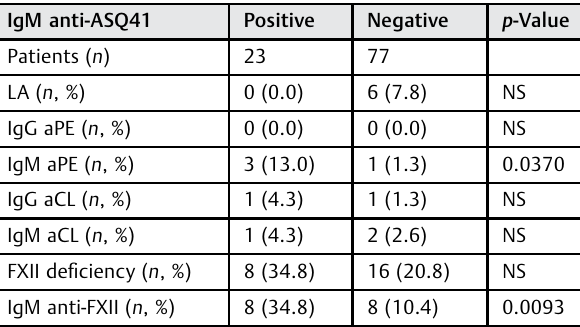
Table 2 Antiphospholipid antibodies, FXII de fi ciency, and anti- FXII in 100 patients with recurrent pregnancy loss